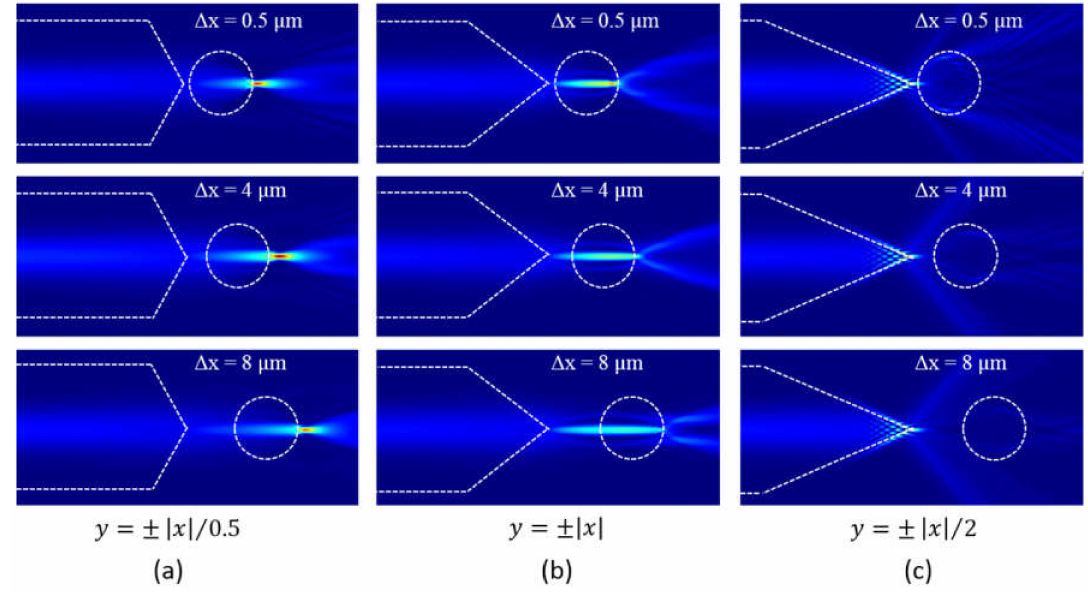
Figure 4. The light intensity distribution in the model consisting of the microsphere and the axicon lensed fiber with the tapered outline equation of ( a ) y = ± | x |/0.5; ( b ) y = ± | x |; and ( c ) y = ± | x